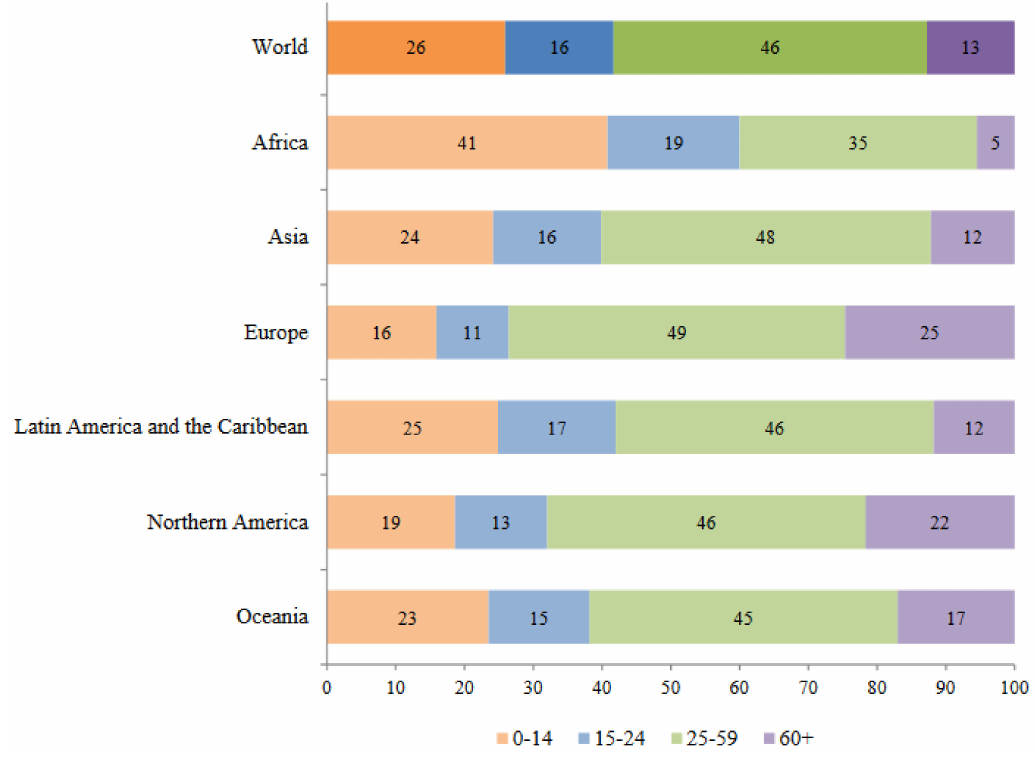
Figure 1. Distribution in percentage by age group and by region. From World Population Prospect: The 2017 Review by United Nations Department of Economic and Social Affairs, United Nations. Reprinted with permission of the United Nations (Copyright